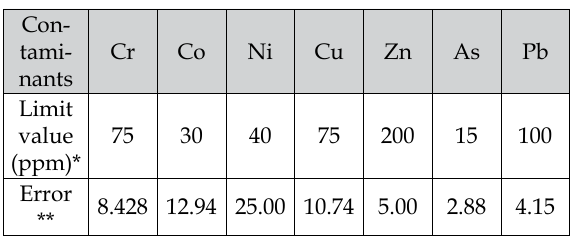
Table 1. XRF measurement errors.